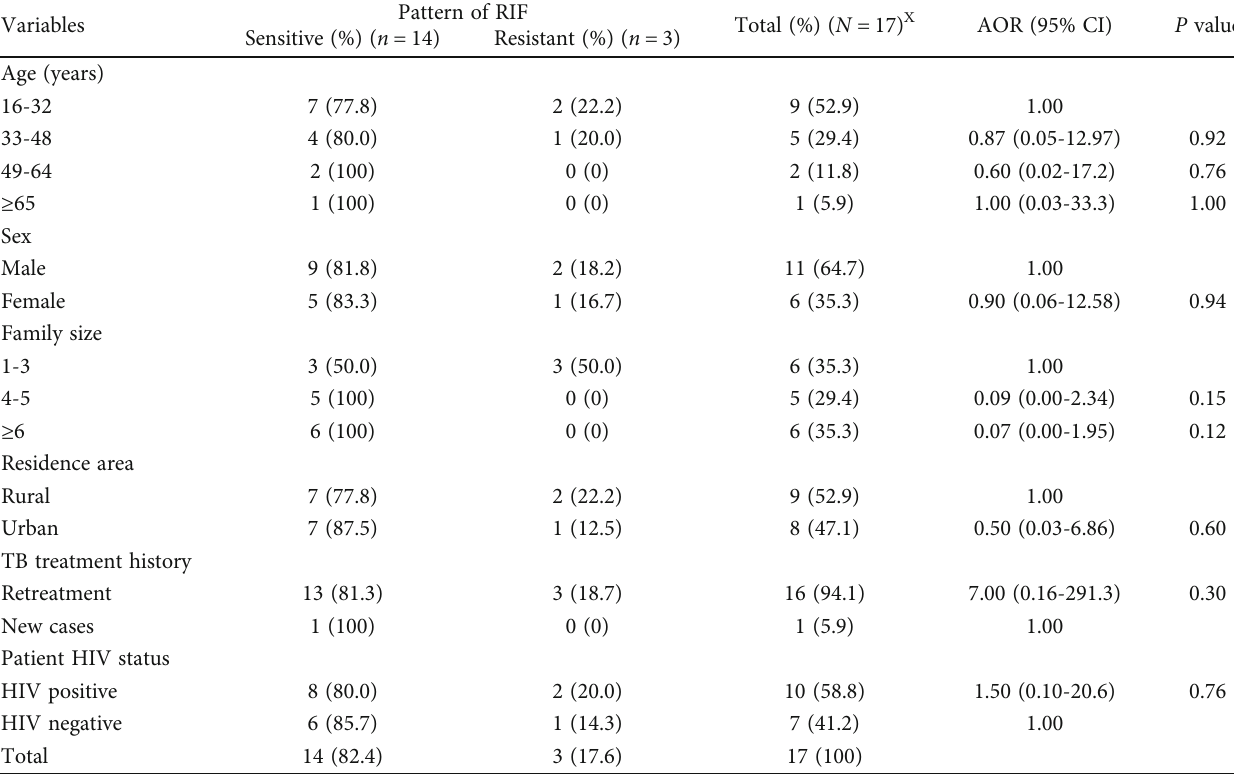
Table 3: Association of patient characteristics to the pattern of RIF at Enat Hospital, Merhabete district, Central Ethiopia, 2020. Pattern of Variables